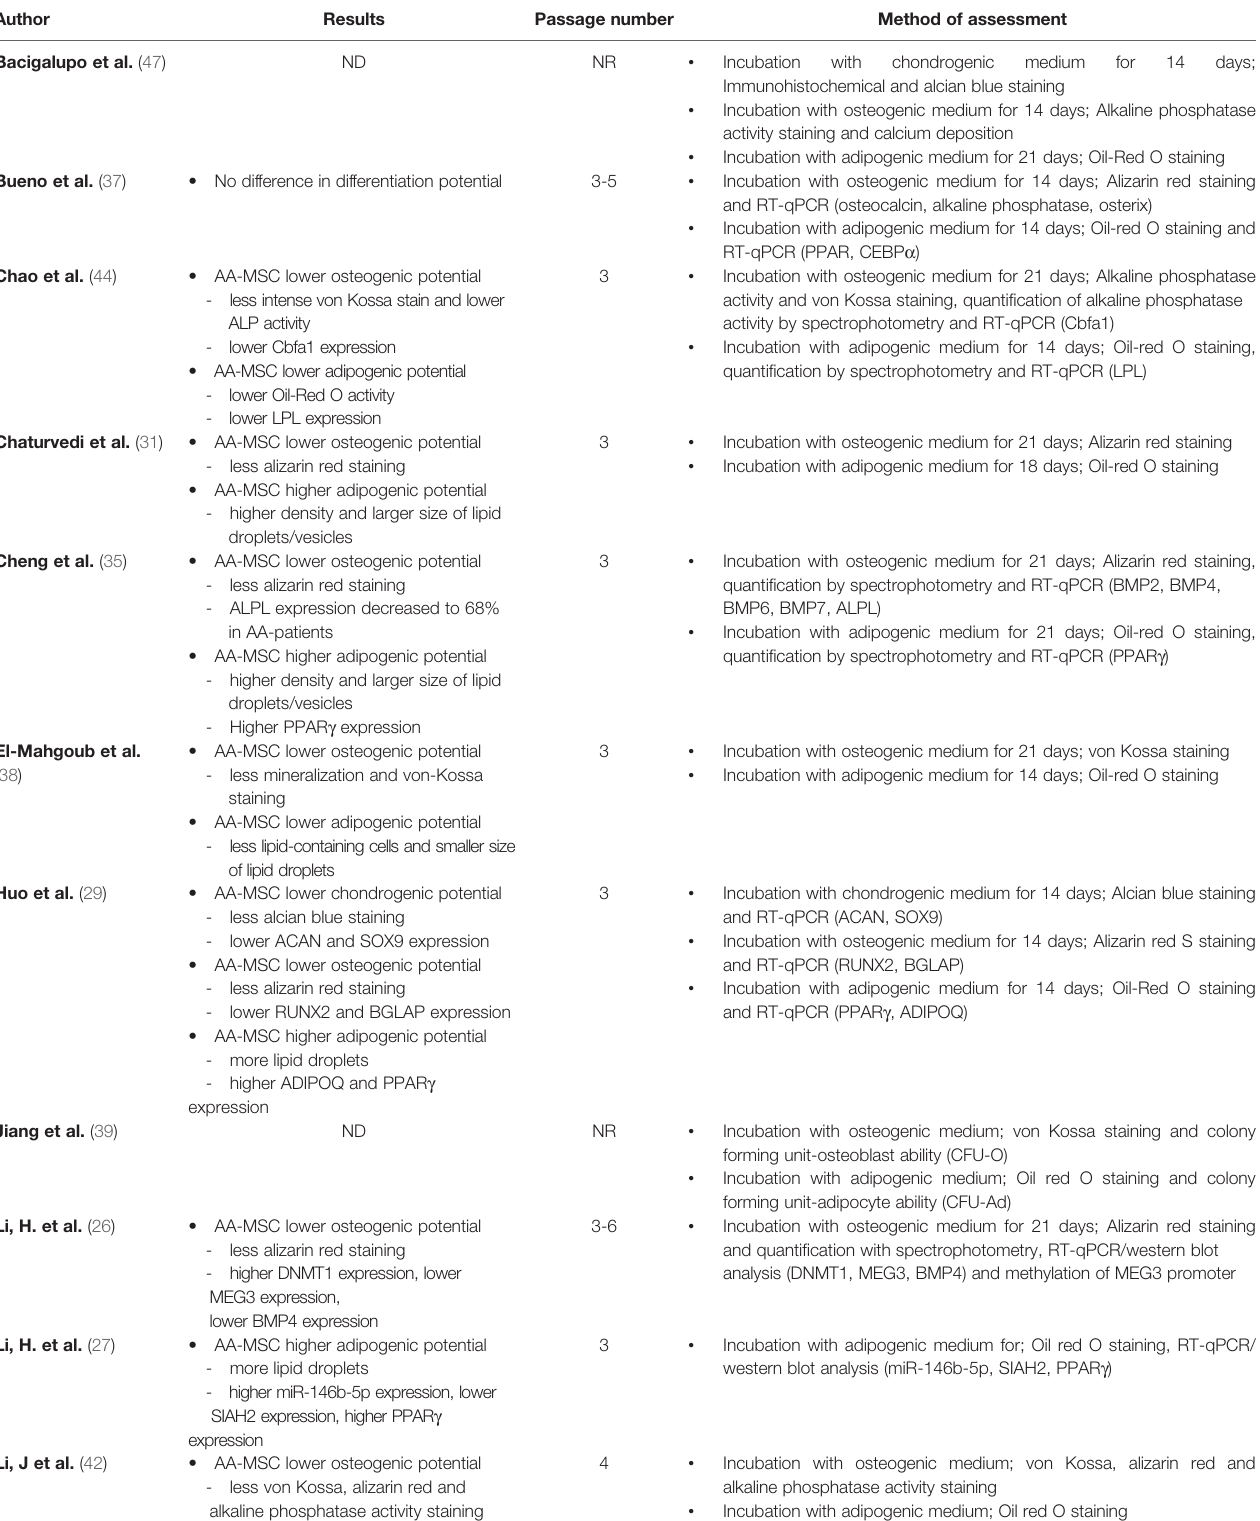
TABLE 7 | Assessment of differentiation